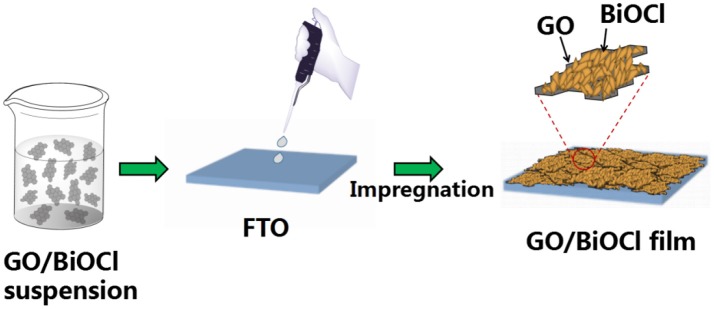
Schematic procedure for fabricating GO/BiOCl film.